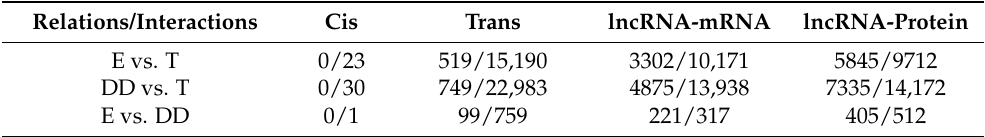
Table 4. Cumulative correlations between DELs and DEGs. Significant correlations between lncRNA and mRNA or proteins in each comparison (number of interactions associated with the sperm motility/all identified